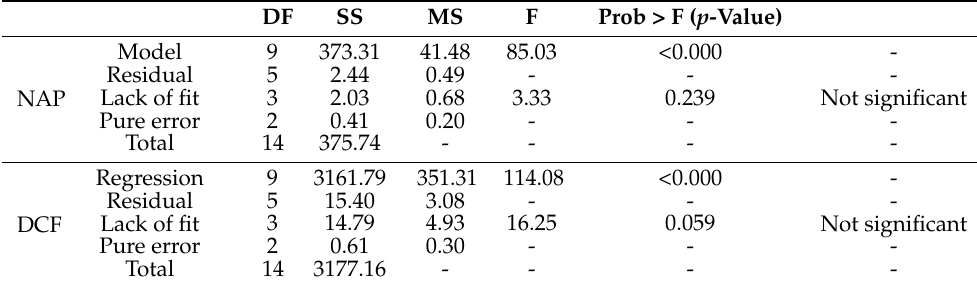
Table 4. ANOVA results of the NAP and DCF quadratic polynomial